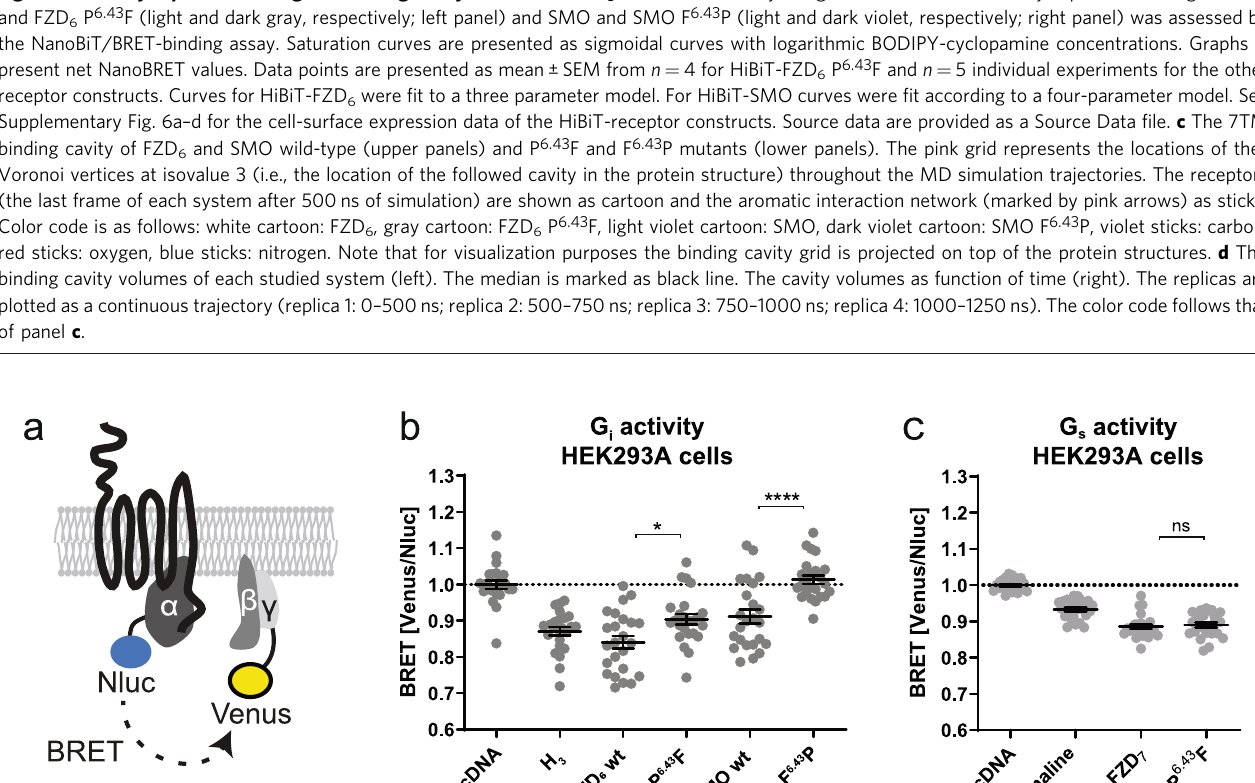
Fig. 3 G protein activation by FZDs and SMO. a Schematic presentation of G i1/s sensor design and assay principle. b G i1 activation by FZD 6 and SMO wild- type and mutants. c G s activation by FZD 7 . Empty vector (pcDNA) transfection was employed as a negative control and the histamine H 3 receptor ( b ) and β µ M isoprenaline ( c ) were used as positive controls. Data are represented as mean ± SEM of three independent experiments 2 AR stimulated with 10 measured in octuplicates. Statistical difference was assessed using One-Way ANOVA followed by Sidak ’ s multiple comparison. * P < 0.05; **** P < 0.0001; ns not signi fi cant. All experiments were conducted in HEK293A cells transiently co-transfected with the indicated G protein sensor and receptor. See Supplementary Fig. 6e for the cell-surface expression of the utilized FZD 6 , FZD 7 , and SMO constructs. Source data are provided as a Source Data fi